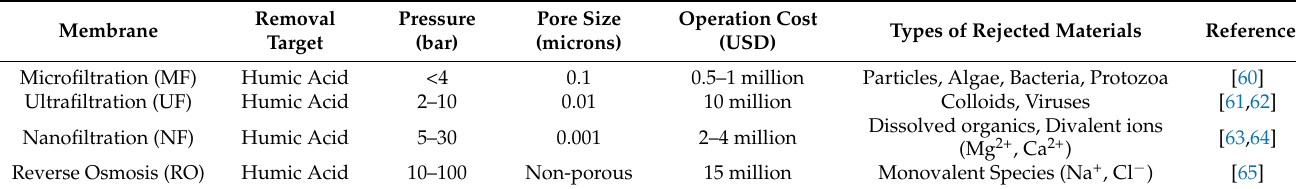
Table 3. Operating factors of different pressure-driven membranes for wastewater